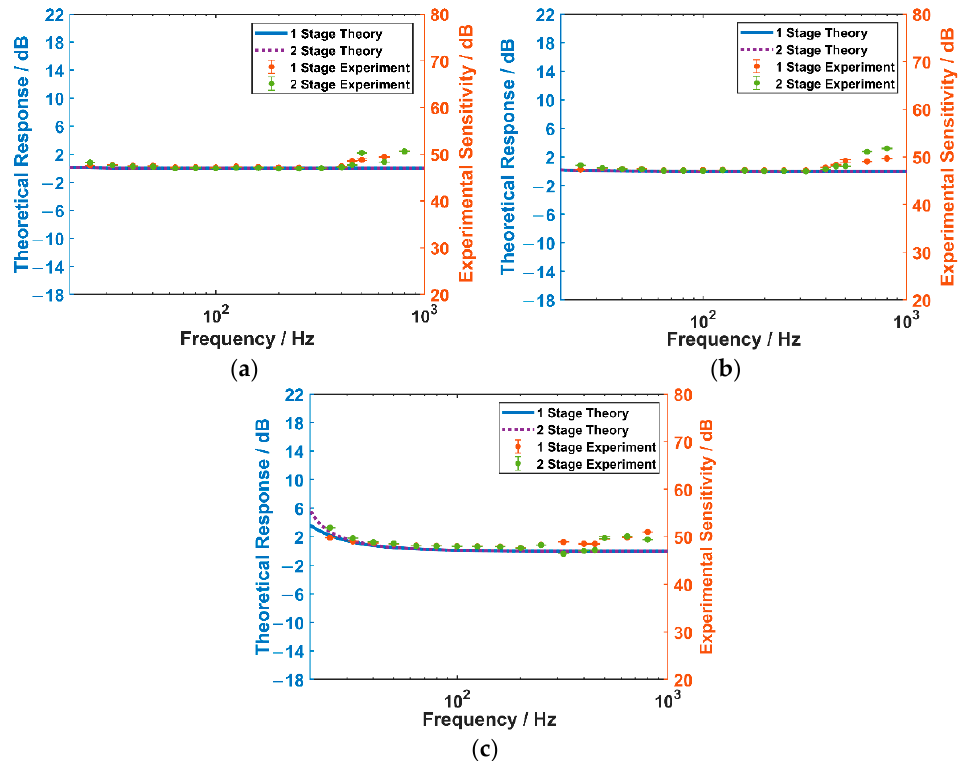
Figure 16. The experimental results of the acceleration sensitivities for the FOVH in two suspension systems: ( a ) X direction; ( b ) Y direction; and ( c ) Z direction.